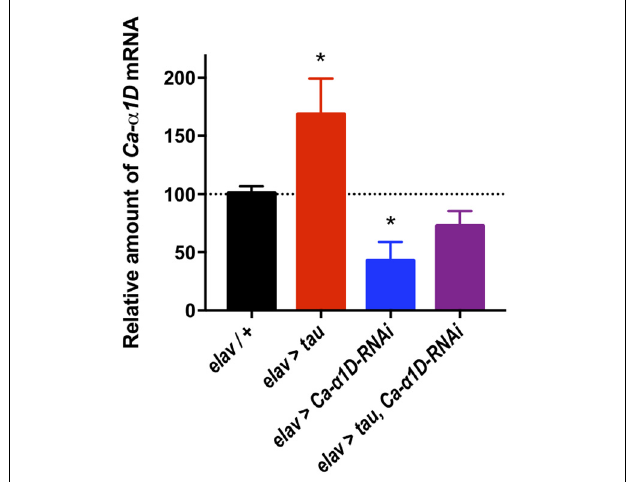
FIGURE 3 | Tau expression increased Ca 2 + channel α 1D mRNA levels. Pan-neuronal Tau expression led to a 68% increase in Ca- α 1D mRNA levels compared to controls, while expressing a RNAi against Ca- α 1D reduced its expression by 58%. Co-expression of the RNAi in tau expressing flies partially restored levels of Ca- α 1D compared to controls. n = 6 biological replicates of 23 or more heads each for all groups. Data analyzed with one-way ANOVA with Holm-Sidak’s post hoc tests. ∗ p <